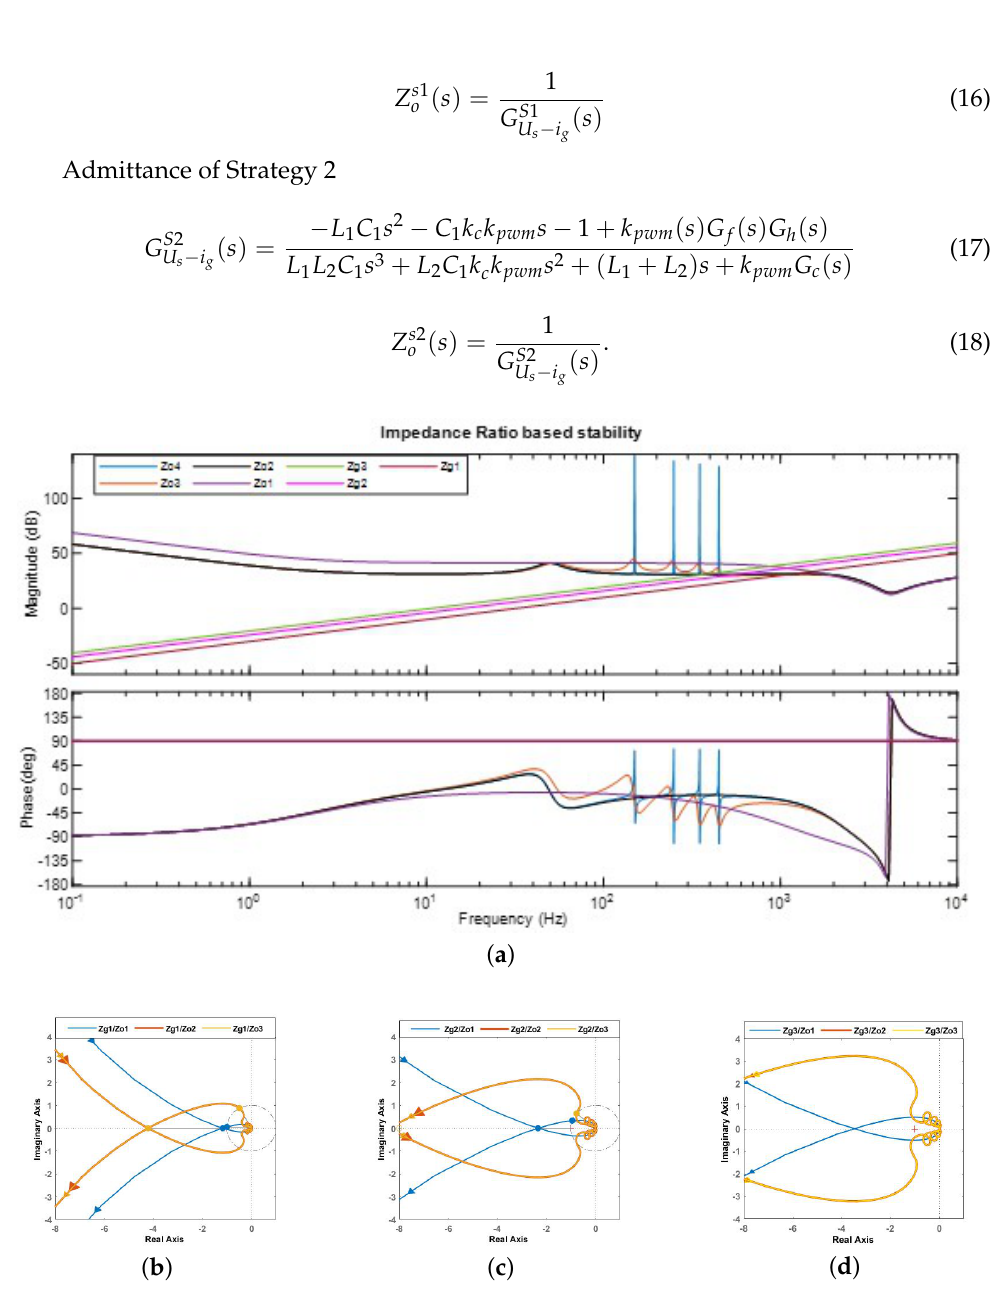
Figure 7. Impedance base stability analysis. ( a ) Bode plot of grid impedance vs. the inverter output impedance. ( b ) Nyquist plot for Strategies 1, 2 and 3 when Z g ( s ) is 5 mH. ( c ) Nyquist plot for Strategies 1, 2 and 3 when Z g ( s ) is 10mH. ( d ) Nyquist plot for Strategies 1, 2 and 3 when Z g ( s ) is 15